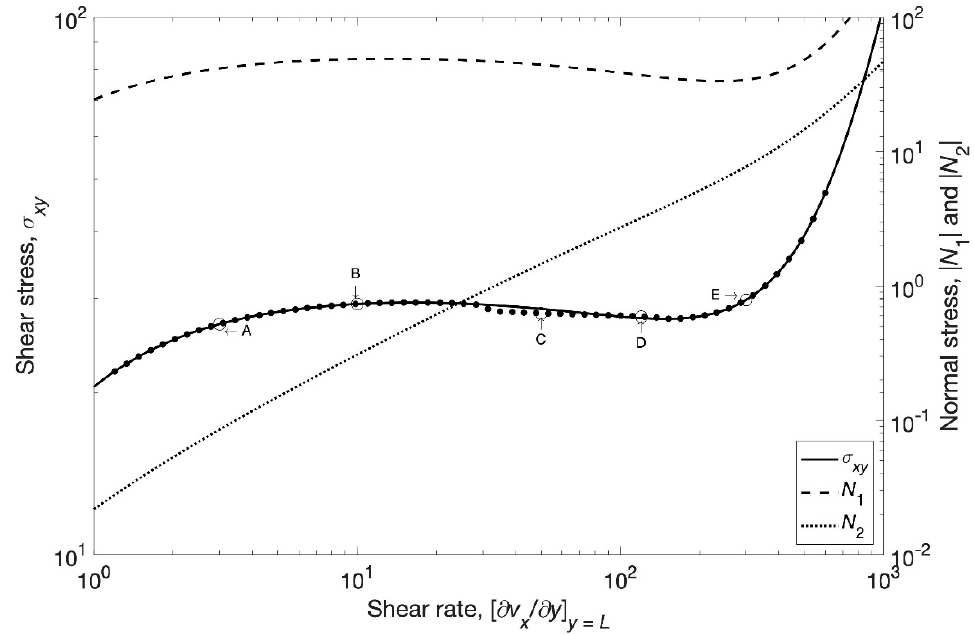
Figure 1. Steady state constitutive curves obtained under controlled shear rate starting from rest. Parameters used in the simulations are: c 0 = 5 wt %, ϕ ∞ = 847 m · s · kg − 1 , τ σ = 1.06 s, η 0 = 36.56 kg m − 1 s − 1 , k 0 = 3.28 × 10 − 4 m s − 1 kg − 1 , λ = 0.136 s, ϑ = 0.0061 s, ρ = 1000 kg m − 3 , D = 1 × 10 − 5 m 2 s − 1 , D (cid:48) = 1 × 10 − 11 m 2 s − 1 , ψ 2 = 0.0388 s.